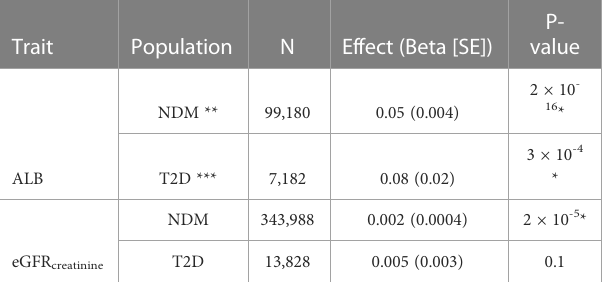
GRS CUBN , A genetic risk score based on a combination of the four CUBN genetic variants (minor alleles); N, sample size; Beta, Beta estimate; SE, standard error; ALB, continuous urinary albumin (mg/L, natural log-transformed); eGFR creatinine , estimated glomerular fi ltration rate (natural log-transformed); NDM, without Diabetes Mellitus; T2D, Type 2 diabetes.*Statisticallysigni fi cant(P<0.05).**outoftotal107,276individualswithcontinuous urinary albumin levels. *** out of total 7,777 individuals with continuous urinary albumin